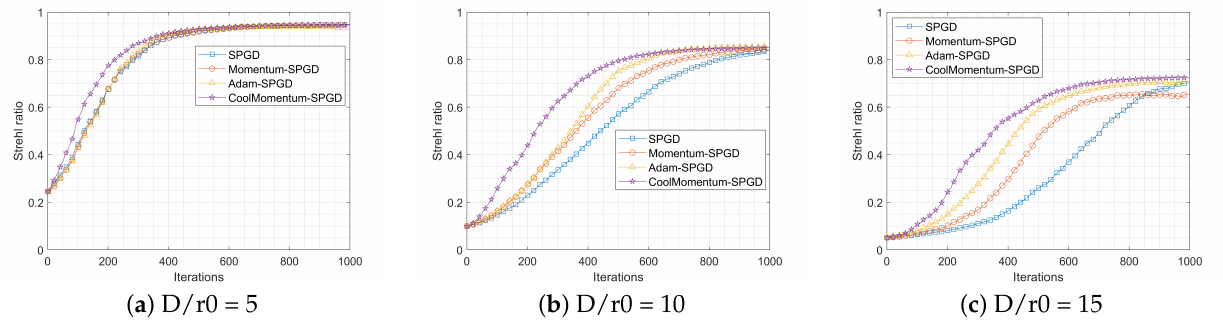
Figure 3. The averaged Strehl ratio adaptation curves of CoolMomentum-SPGD and other counter- parts under turbulence strength D/r0 = 5, 10, and